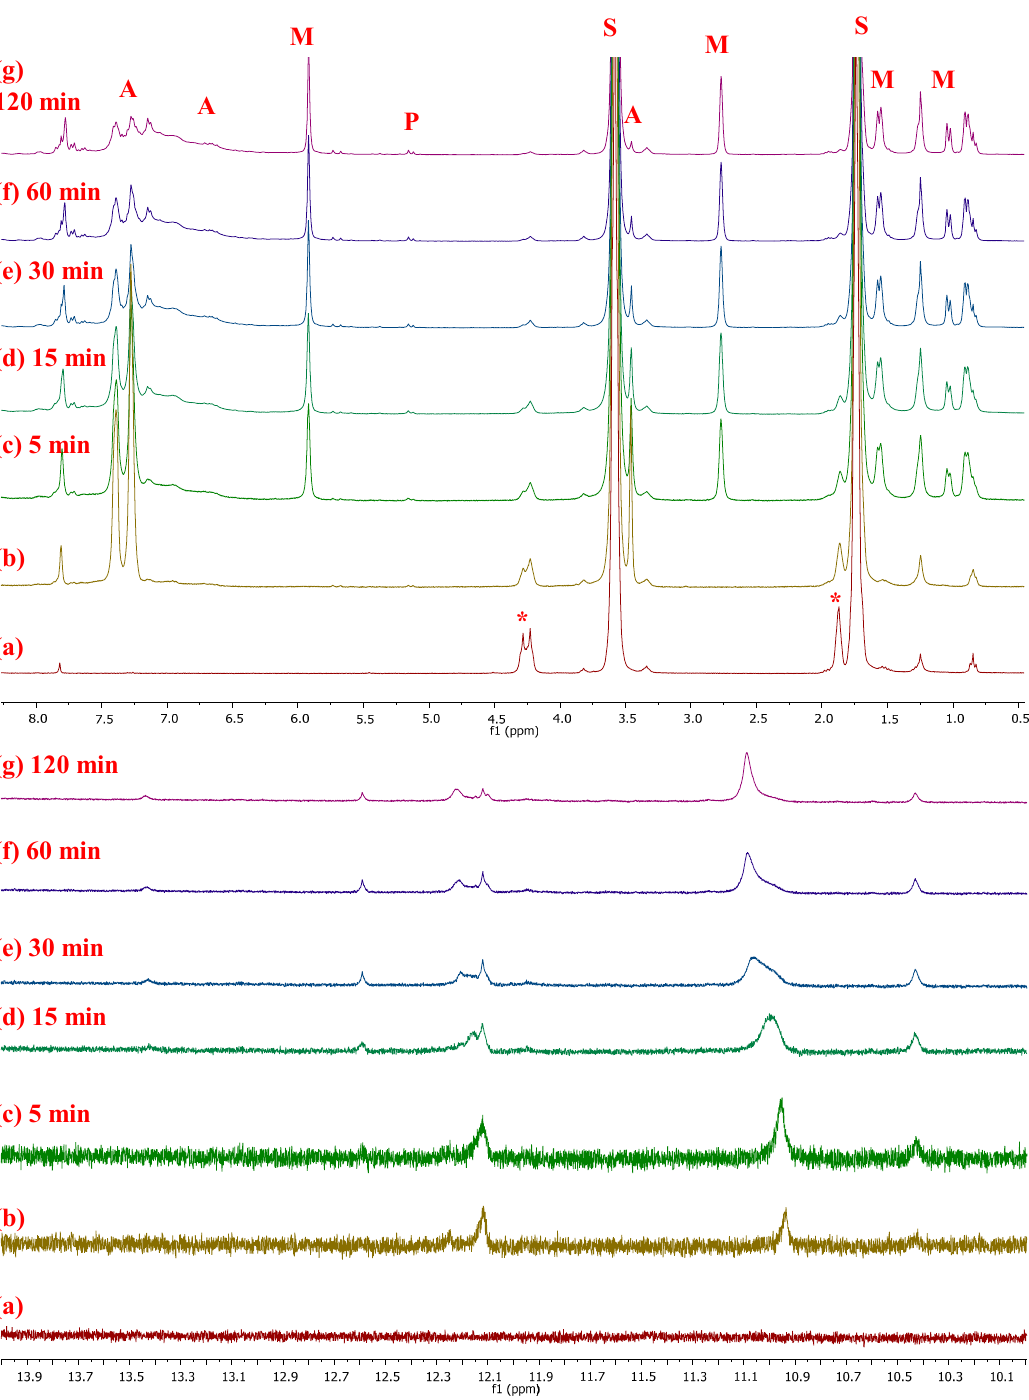
Figure 1. 1 H-NMR spectra (top: region 8.5–0.5 ppm; bottom: region 14.0–10.0 ppm) of: 1 ( a ), from the reaction of 1 (8.0 mg, 0.008 mmol) with PA (5 µ L, 4.6 mg, 0.05 mmol) ( b ) and from the reaction of 1 / PA with NBE (5 mg, 0.05 mmol) in d 8 -THF at various time intervals, as indicated ( c – g ). Signals denoted by “ * ” are due to coordinated THF of 1 , “S” to residual solvent, “M” to NBE , “P” to PNBE and “A” to PA and/or PPA .